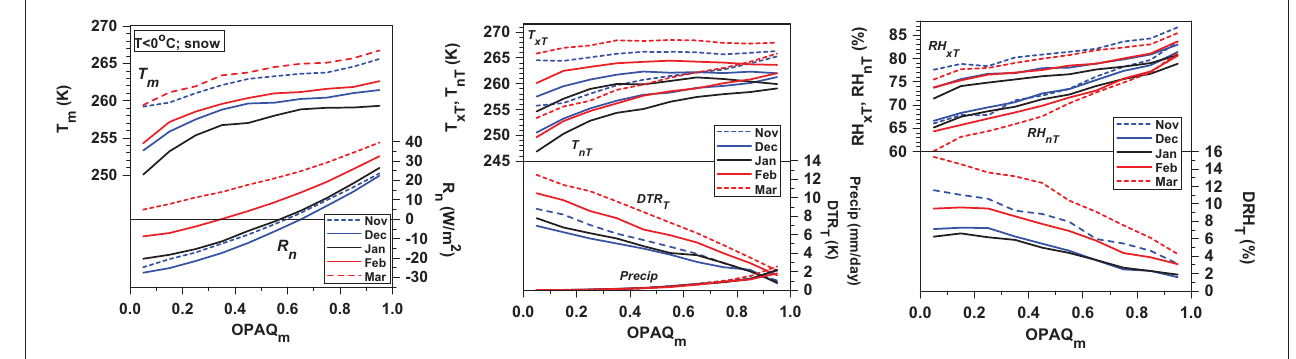
FIGURE 14 | Monthly T m and R n (left); (center) T xT , T nT , DTR T , and precipitation; and (right) RH xT , RH nT , DRH T as a function of OPAQ m .